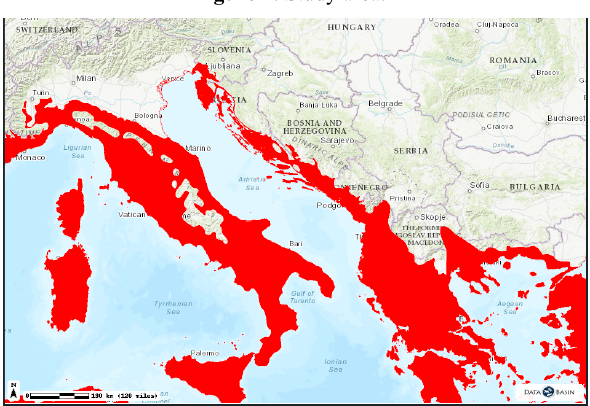
Figure 1 . Study area.